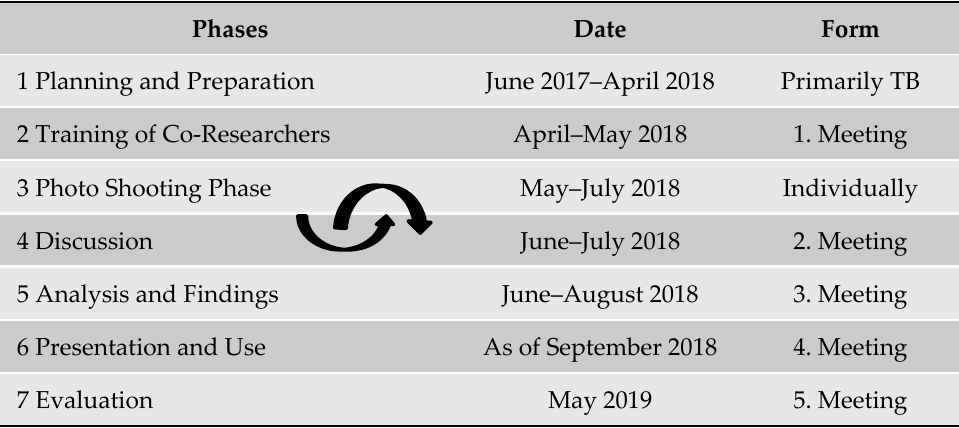
Table 1. Collective Research